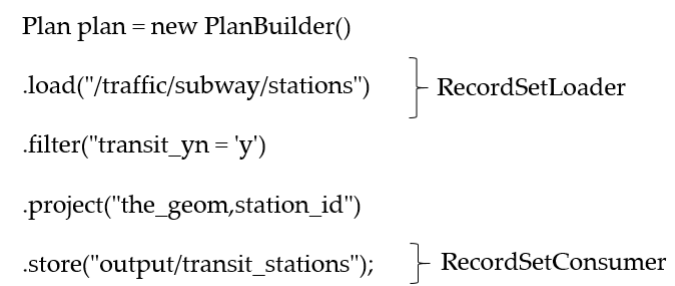
Figure 5. A Marmot code of an example of RecordSetLoader and RecordSetConsumer.